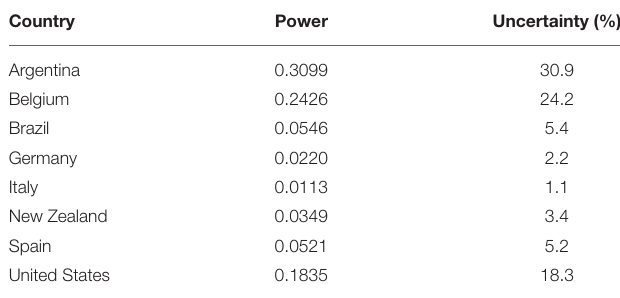
TABLE 2 | Pandemic’s uncertainty (up to May 23, 2020).